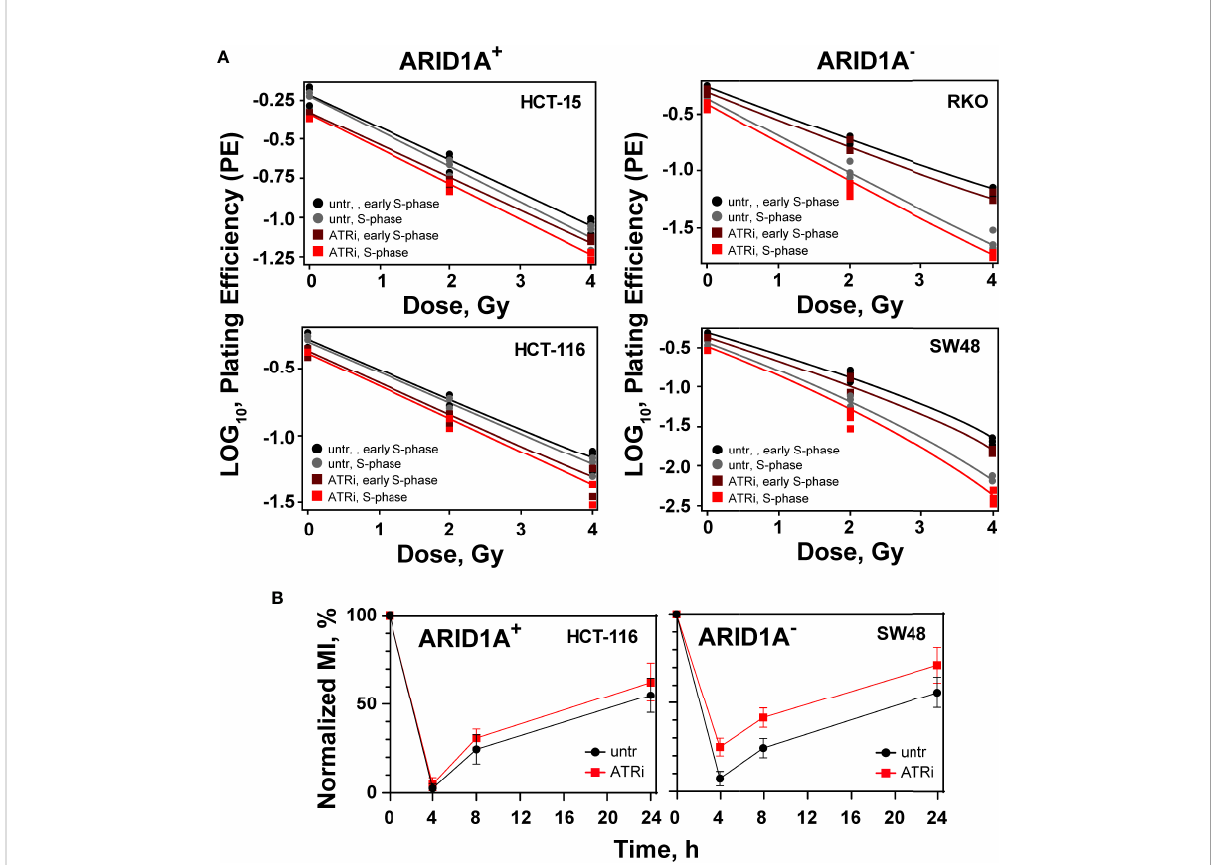
FIGURE 2 Cell cycle effect of ATRi/ARID1A. (A) Synchronized cells in early S phase and mid S phase were pre-treated for 1 h with VE822 and irradiated thereafter with 0 Gy, 2 Gy and 4 Gy. Plating ef fi ciency of sham treated (untr) and VE822 treated (ATRi) cells were plotted as log10 for ARID1A + and ARID1A - cell lines. (B) Exit from G2 phase into the M phase was measured after treatment with VE822 and irradiation in ARID1A - SW48 and ARID1A + HCT116 cell lines. Fraction of phospho-histone H3 positive cells were plotted against time after irradiation. MI = phospho-histone H3 in radiation/phospho-histone H3 in no-radiation × 100%. Results of 3 independent experiments are shown for CRC cell